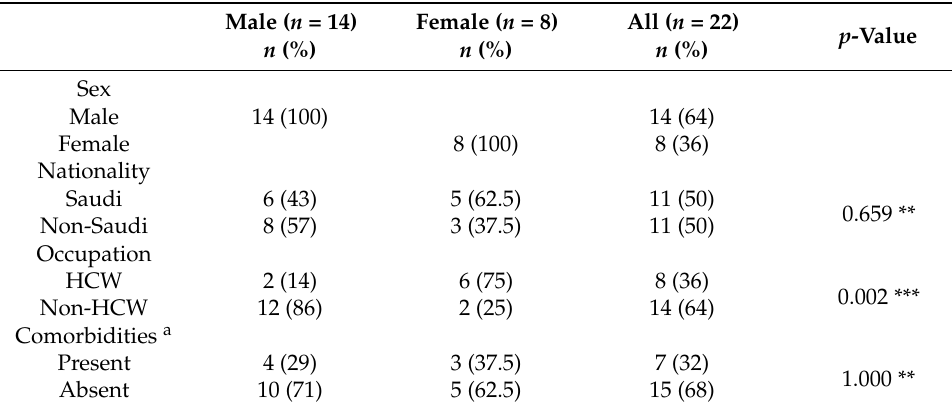
Table 2. The demographic features and characteristics of the participants ( n = 22).